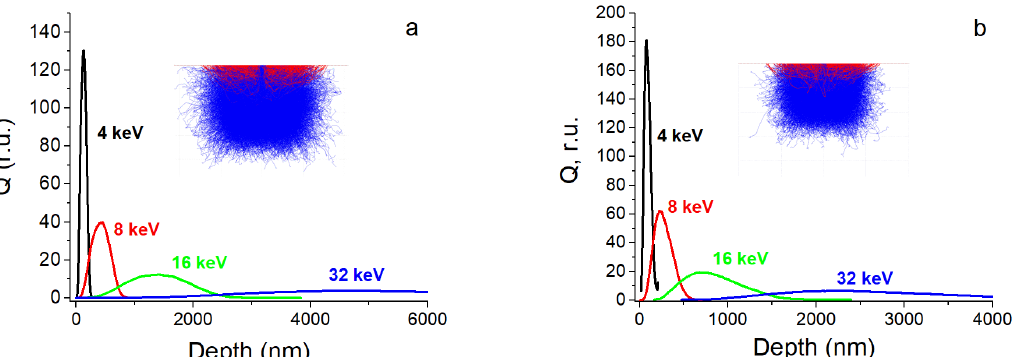
Figure 5. Results of CASINO of depth charge distribution for Menzel ( a ) and BF16 ( b ) glasses. Insets: CASINO modeling of electron distribution for electron energy 4 keV, blue color corresponds to captured electrons and red to backscattered electrons.